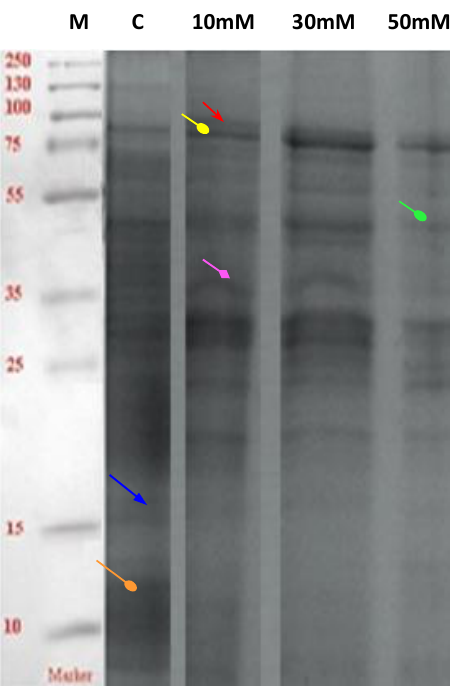
Fig. 3. Polypeptide bands on gel electrophoresis (SDS- PAGE 12%). Control group (C) and Cd(NO 3 ) 2 treated cell (10, 30 and 50 mM ) for 3 days, as well as molecular weight markers (M). Arrows mark the change in the polypeptide